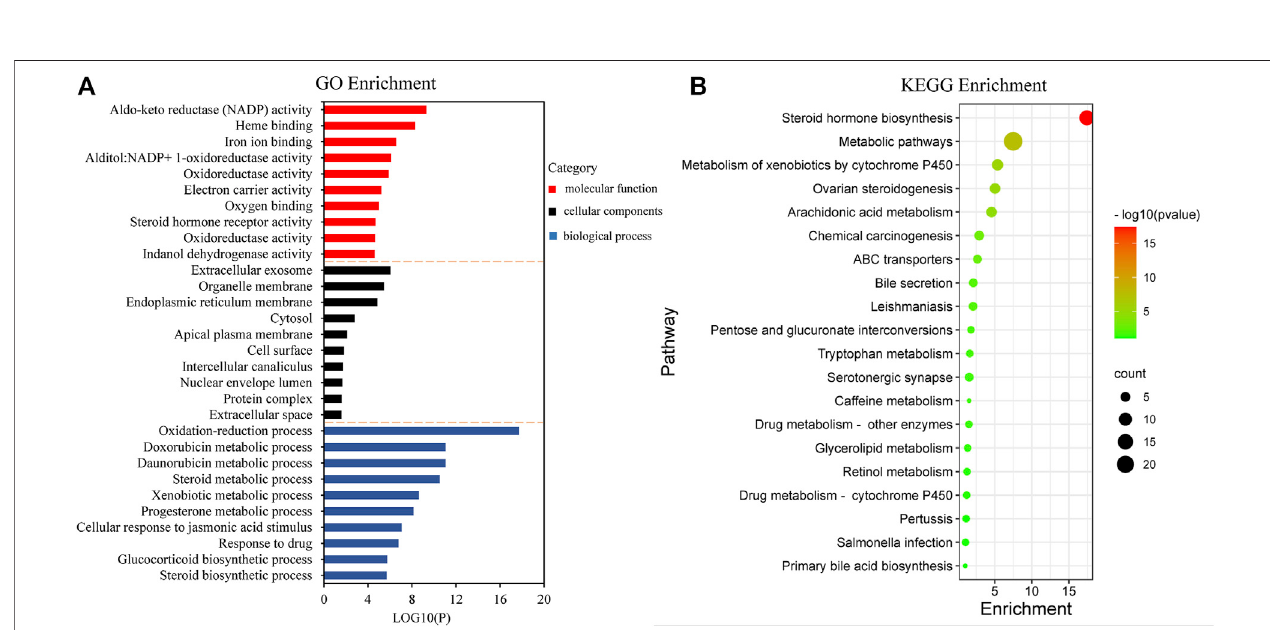
FIGURE 5 | Gene Ontology (GO) term performance and pathway enrichment analysis of common targets. (A) GO term performance by biological process (BP), cellular component (CC), and molecular function (MF). (B) Pathway enrichment analysis by the Kyoto Encyclopedia of Genes and Genomes (KEGG).